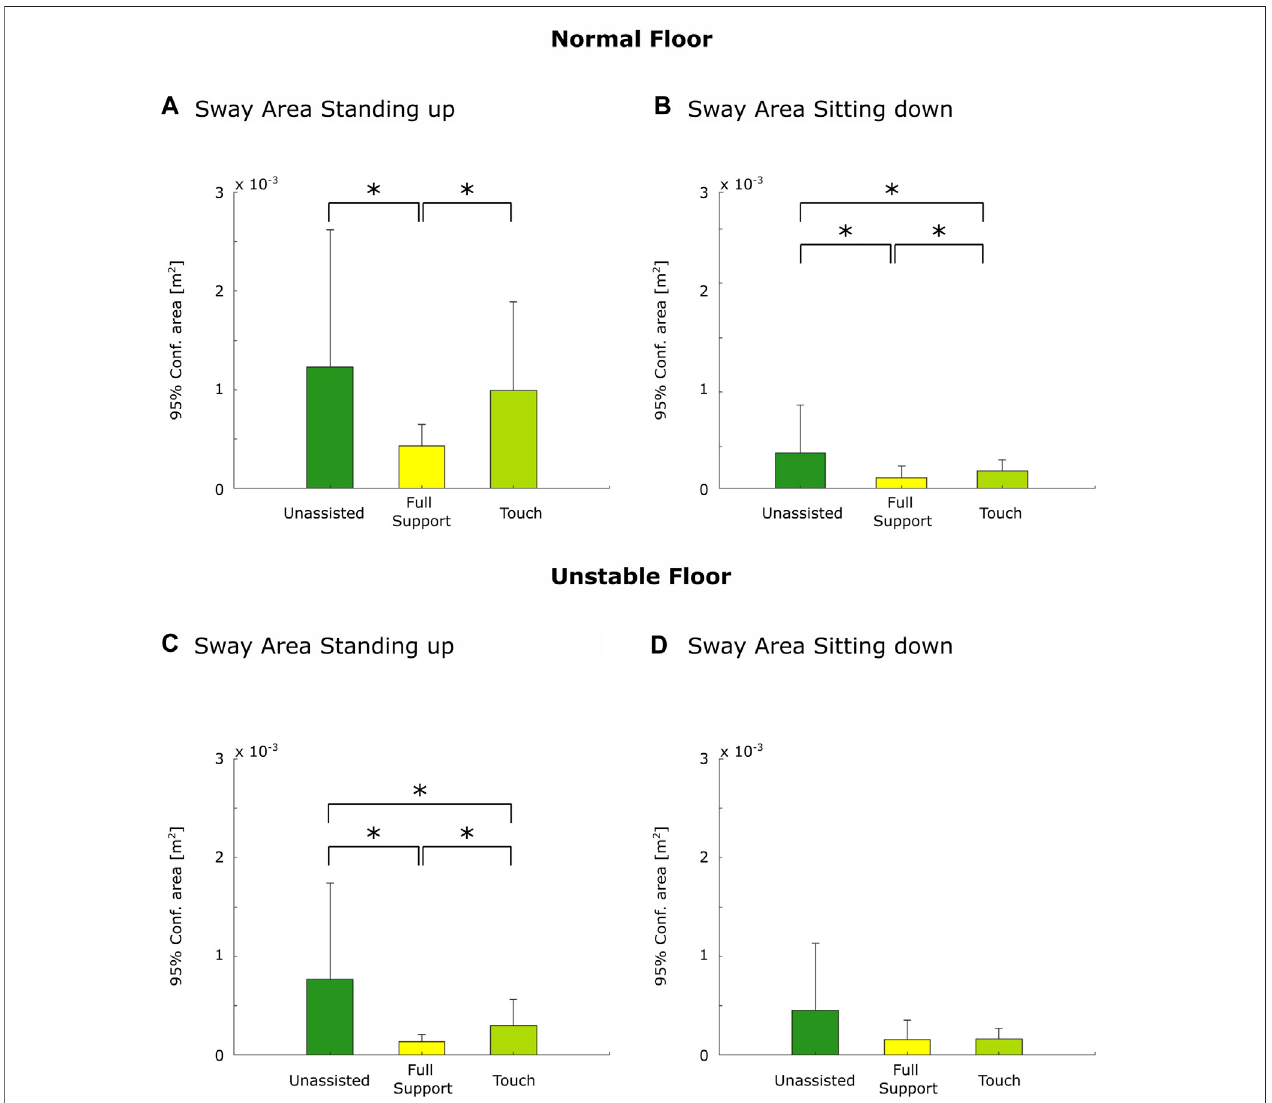
FIGURE 4 | 95% con fi dence ellipse (sway) area. Standing up under normal fl oor (A) and unstable fl oor conditions (C) and sitting down under normal (B) and unstable fl oor conditions (D) . The asterisk depicts post hoc signi fi cant differences with p ≤ 0.05 (Holm – Bonferroni corrected).